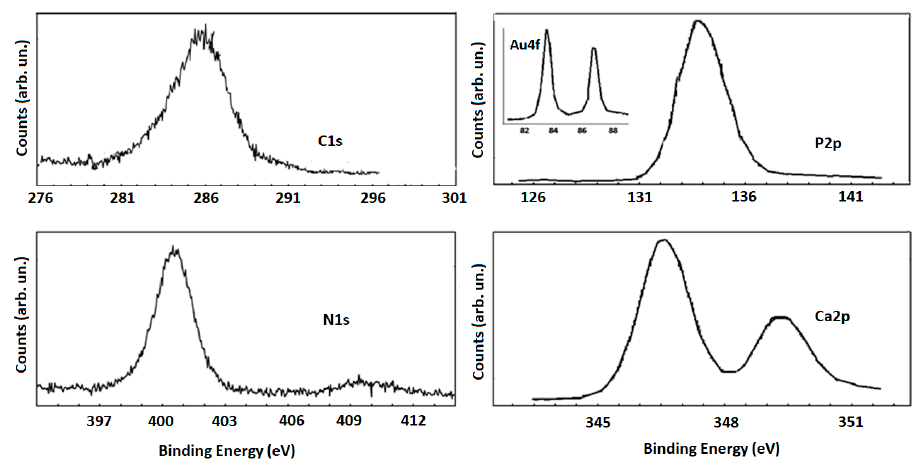
Figure 5. High-resolution XPS spectra of C1s, P2p, N1s, and Ca2p lineshapes.